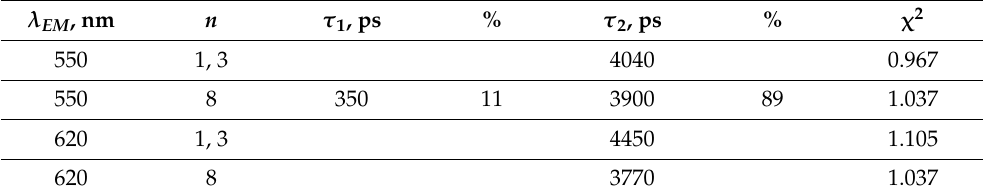
Table 5. PL lifetimes for CdTe-2416SL mixtures depending on λ EM and the concentration of